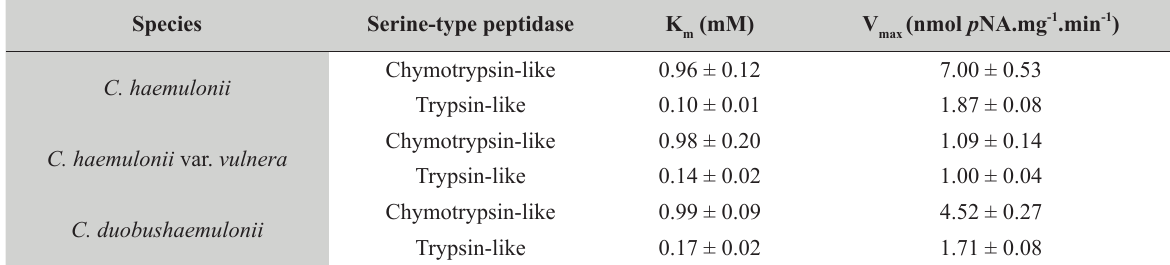
Kinetic parameters of the extracellular serine peptidase activities released by C. haemulonii species